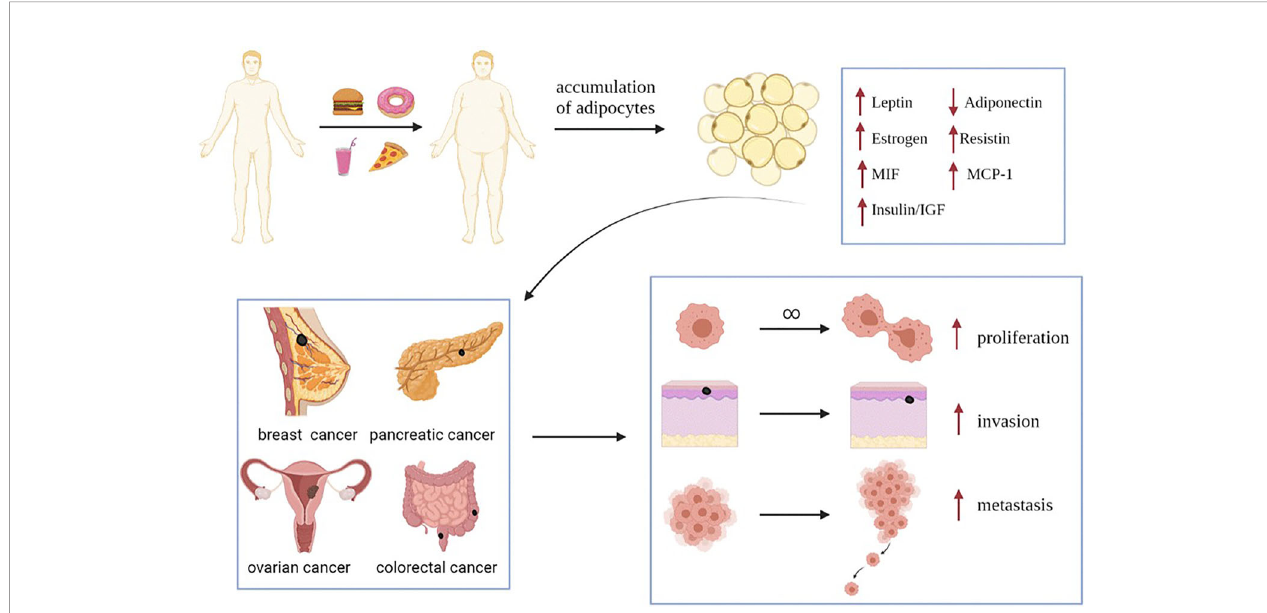
FIGURE 1 | Obesity increased the expression of leptin, estrogen, resistin, MIF, MCP-1 and insulin/IGF, and decreased the expression of adiponectin. These changes in the expression levels of adipokines and hormones will promote the progress of obesity related-tumors (such as breast cancer, pancreatic cancer, ovarian cancer and colorectal cancer), and promote the proliferation, invasion and metastasis of tumor cells. MIF, Macrophage migration inhibitory factor; MCP-1, Monocyte chemoattractant protein-1; IGF, insulin-like growth